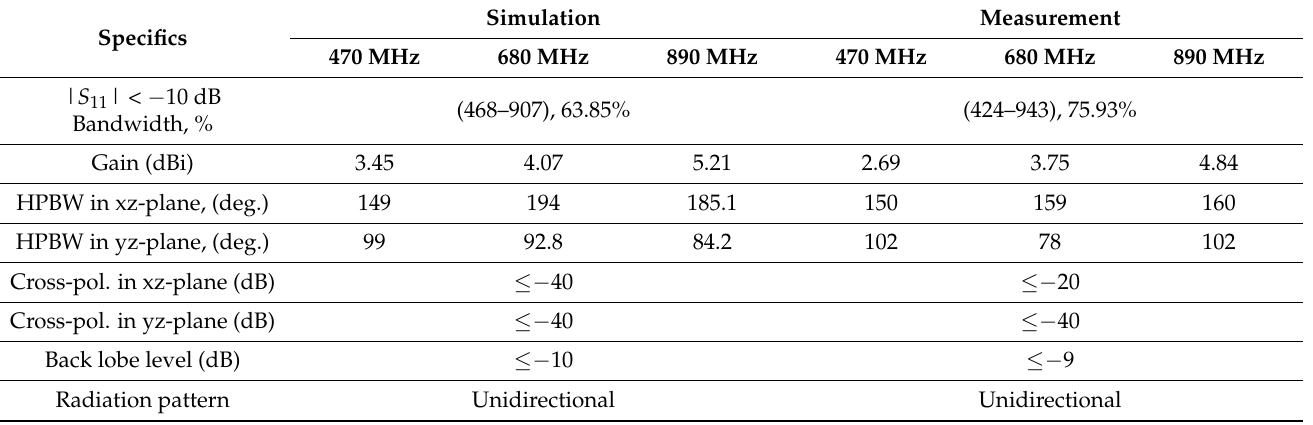
Table 2. Simulated and measured performances of the portable wideband directional antenna scheme.